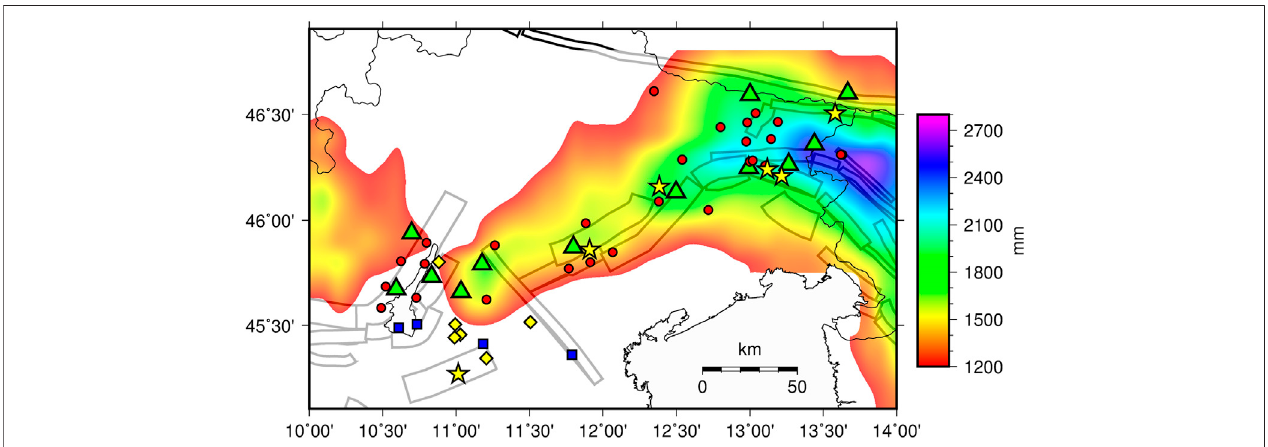
FIGURE 5 | Relationship between the occurrence of M ≥ 4.8 earthquakes and the evolution of sc-PDSI in northeastern Italy in the time period 1901 – 2012 (in grey the time period 1934 – 2012): (A) earthquakes (red bars) and sc-PDSI time series (thin blue line) with the indication of its smoothed version obtained by kernel regression using asmoothingbandwidth ± 2 years(thickblueline)andits trendestimated bylinearregression(dashedblue line); (B) earthquakes(redbars)and detrendedsc-PDSI (only values larger than 1, blue bars).